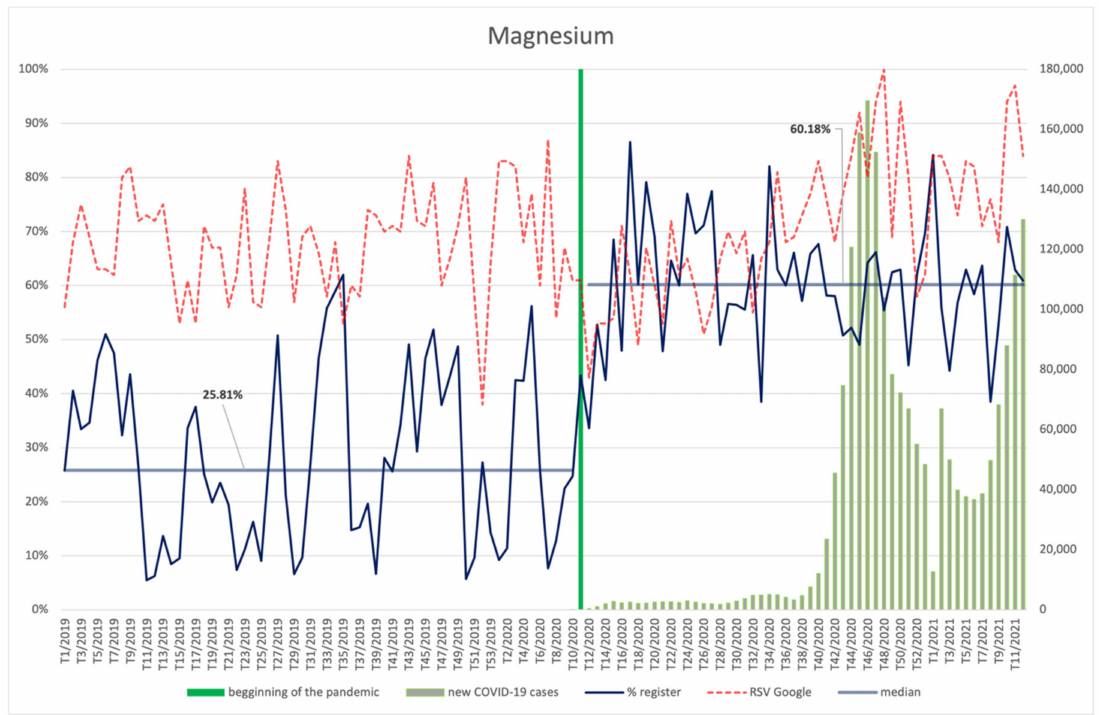
Figure 16. Comparison between the number of new registrations of products containing magnesium, the number of COVID-19 cases, and the frequency of search for information on the ingredient in the Google